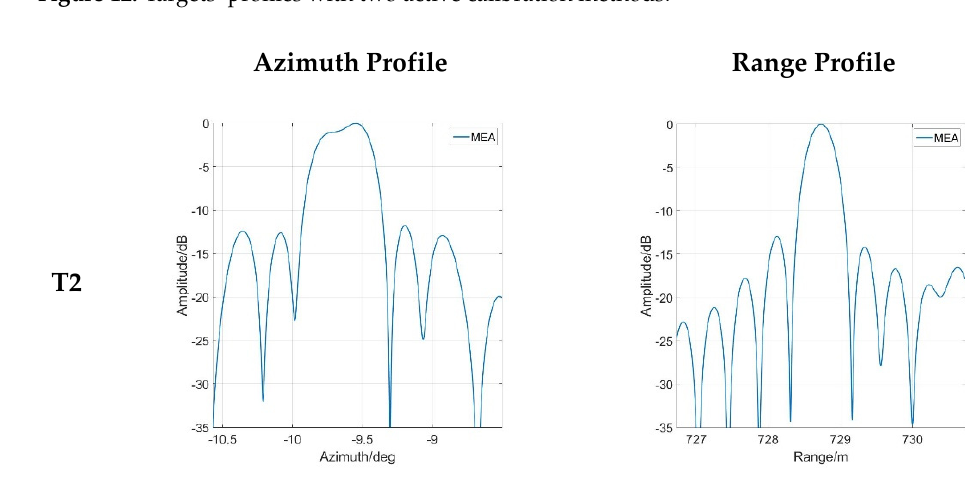
Figure 12. Targets’ profiles with two active calibration methods.